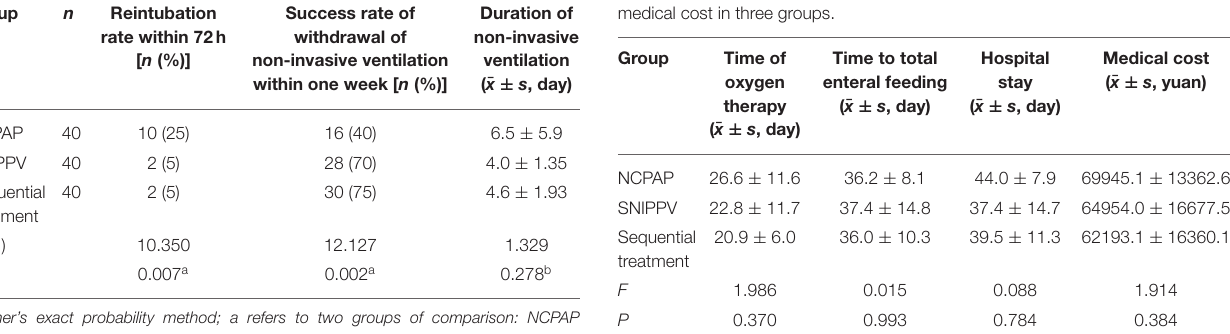
TABLE 4 | Incidence of complications and mortality in three groups [ n (%)]. Group